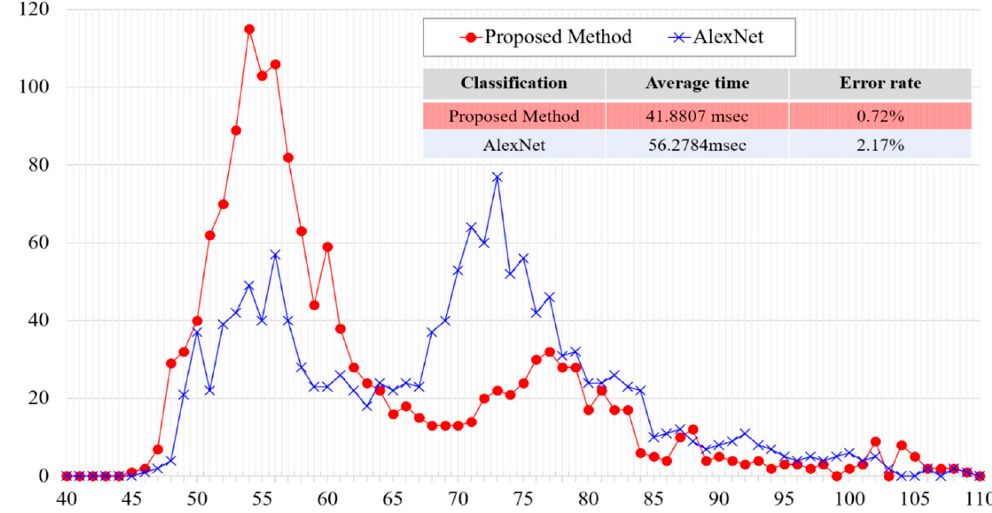
Figure 14. Nose area detection time (in millisecconds).